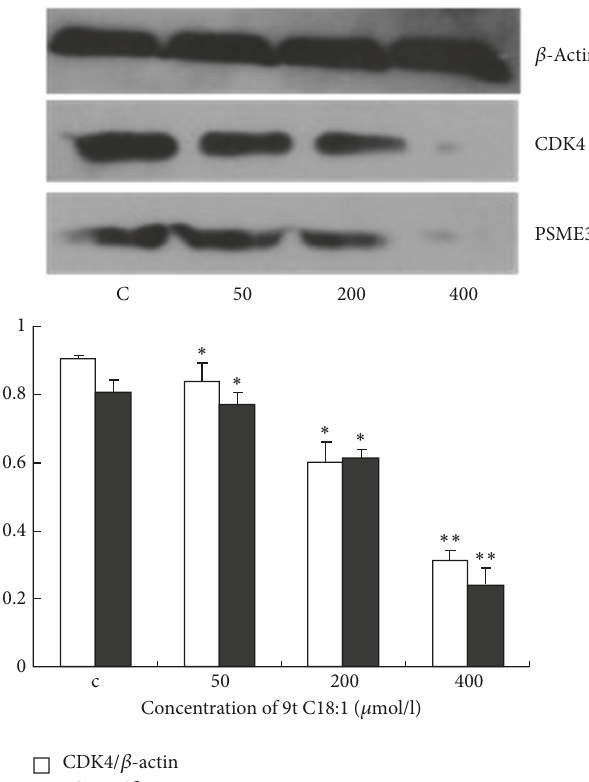
Figure 7: Effect of elaidic acid on expression of CDK 4 and PSME 3 proteins. C: normal HUVEC as control; 50: HUVEC treated with 50 𝜇 mol/Lelaidicacid;200:HUVECtreatedwith200 𝜇 mol/Lelaidic acid; 400: HUVEC treated with 400 𝜇 mol/L elaidic acid. ∗ 𝑝 < 0.05 , ∗∗ 𝑝 < 0.01 when compared to the control